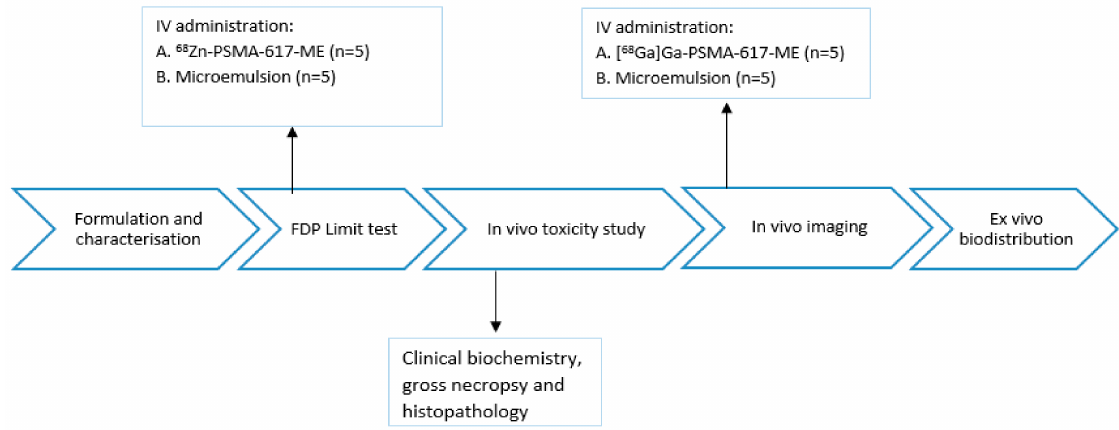
Figure 5. Study design assessing acute in vivo toxicity and tolerability of intravenously administered 68 Zn-PSMA-617 and in vivo imaging of [ 68